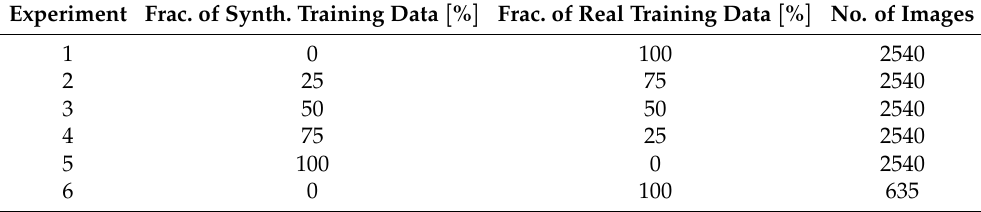
Table 1. Fraction of synthetic and real training data for the different experimental setups.